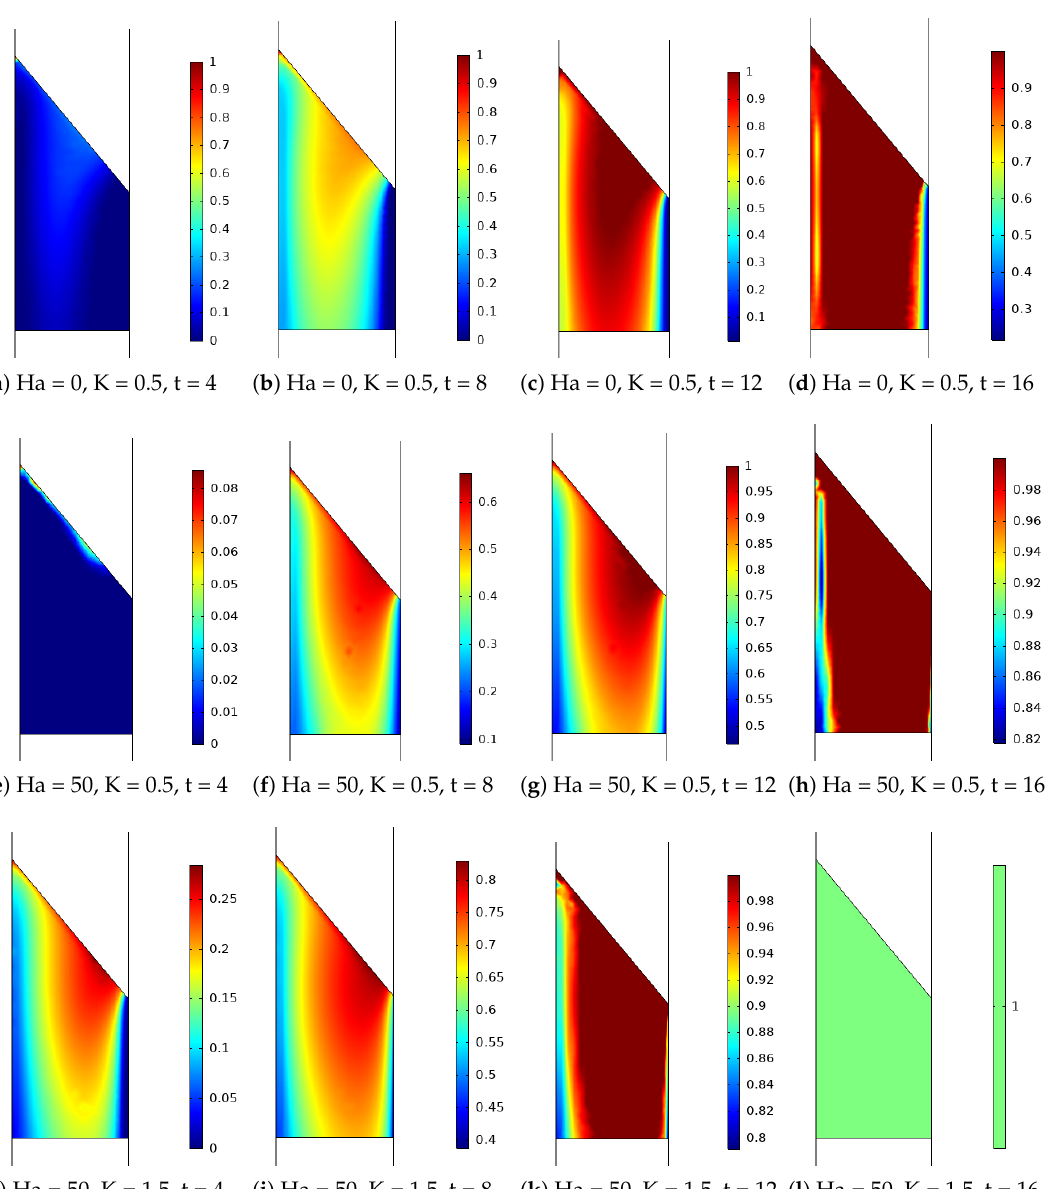
Figure 8. Time evolution of liquid fraction (LFR) distribution for (Ha = 0, K = 0.5) ( a – d ), for (Ha = 50, K = 0.5) ( e – h ) and for (Ha = 50, K = 1.5) ( i – l ) (constant MF, M = 0.5, φ =